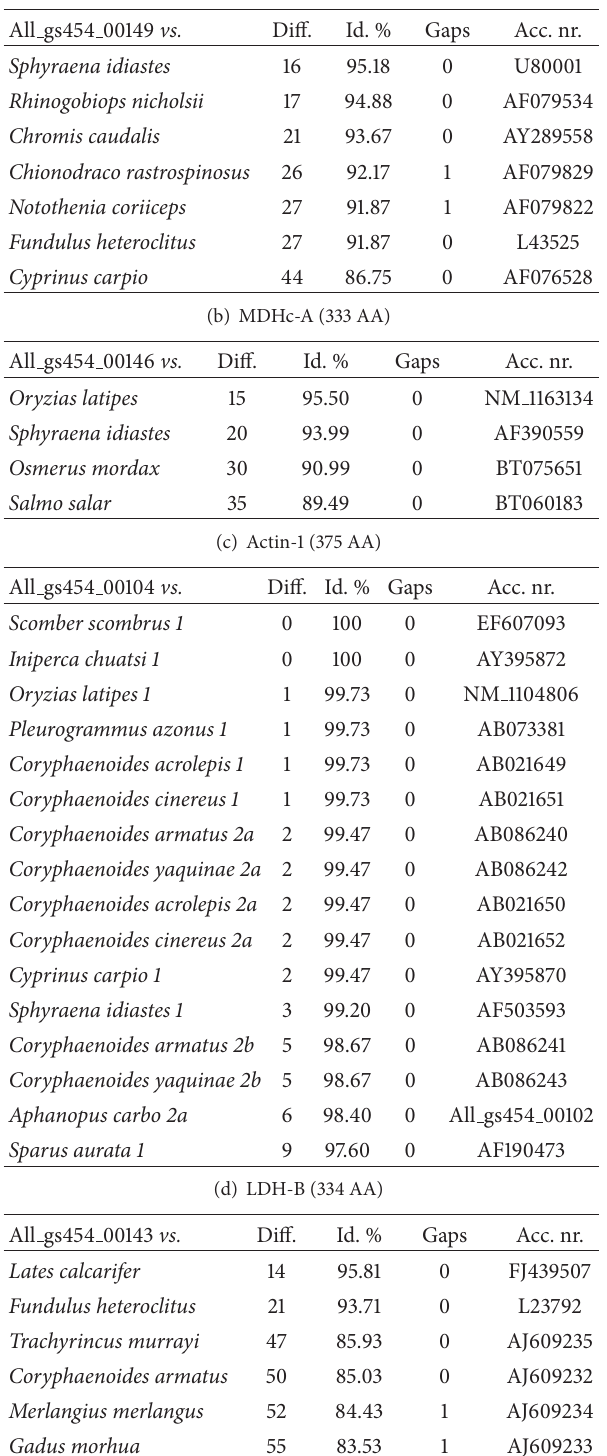
Table 7: Comparison of protein sequences of depth related genes between Aphanopus carbo database (All gs454 xxx) and other fishes. Diff.: amino acid differences; Id. %: percentage of identity; Gaps: number of gaps introduced in the complete alignment and Acc. nr.: NCBI Accession number. 1 Partial sequence; 2 only AA sequence